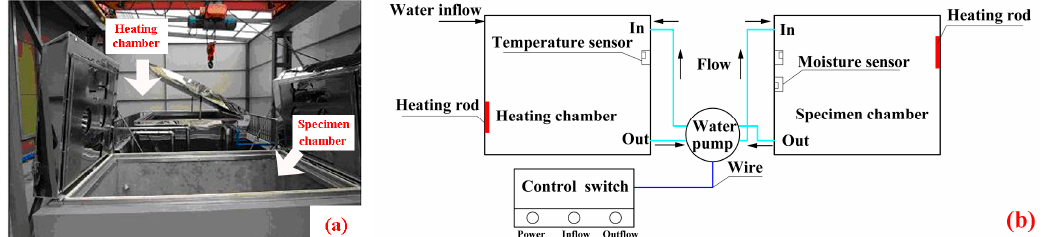
Figure 5. Wet–dry cyclic system, ( a ) physical map; ( b ) sketch map.